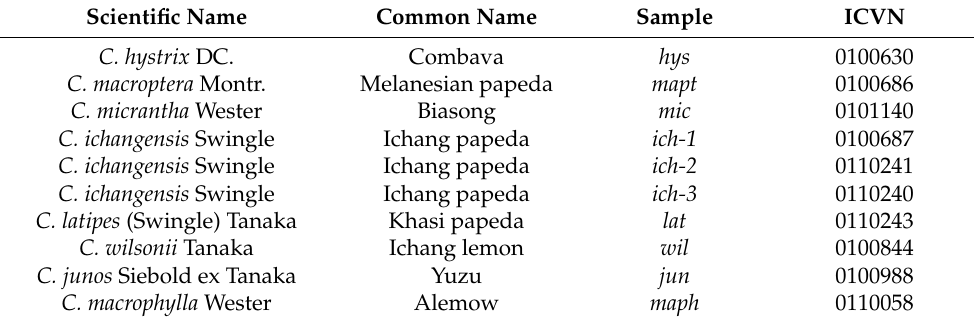
Table 3. List of studied species and